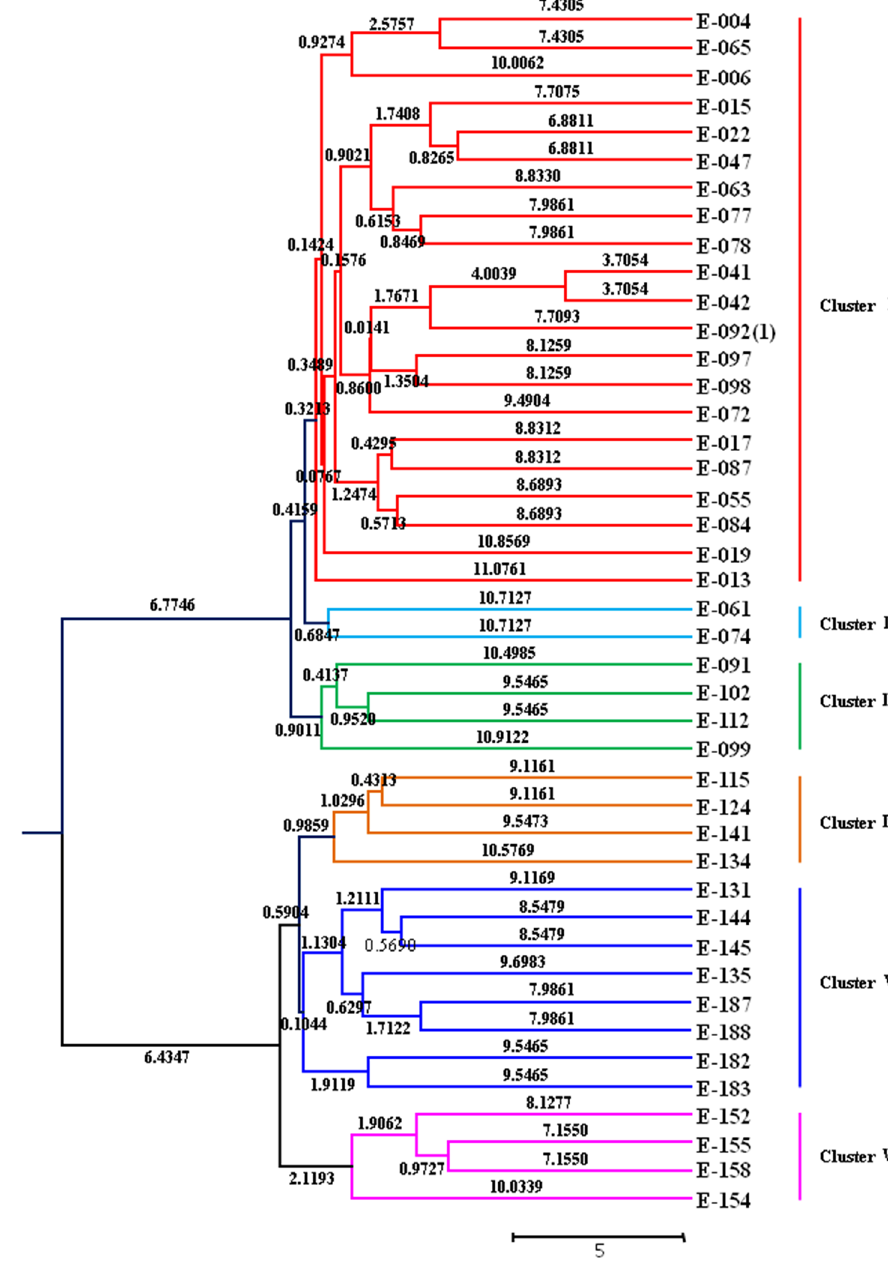
Fig 2. UPGMA-based dendrogram of 43 core collections of E . ophiuroides